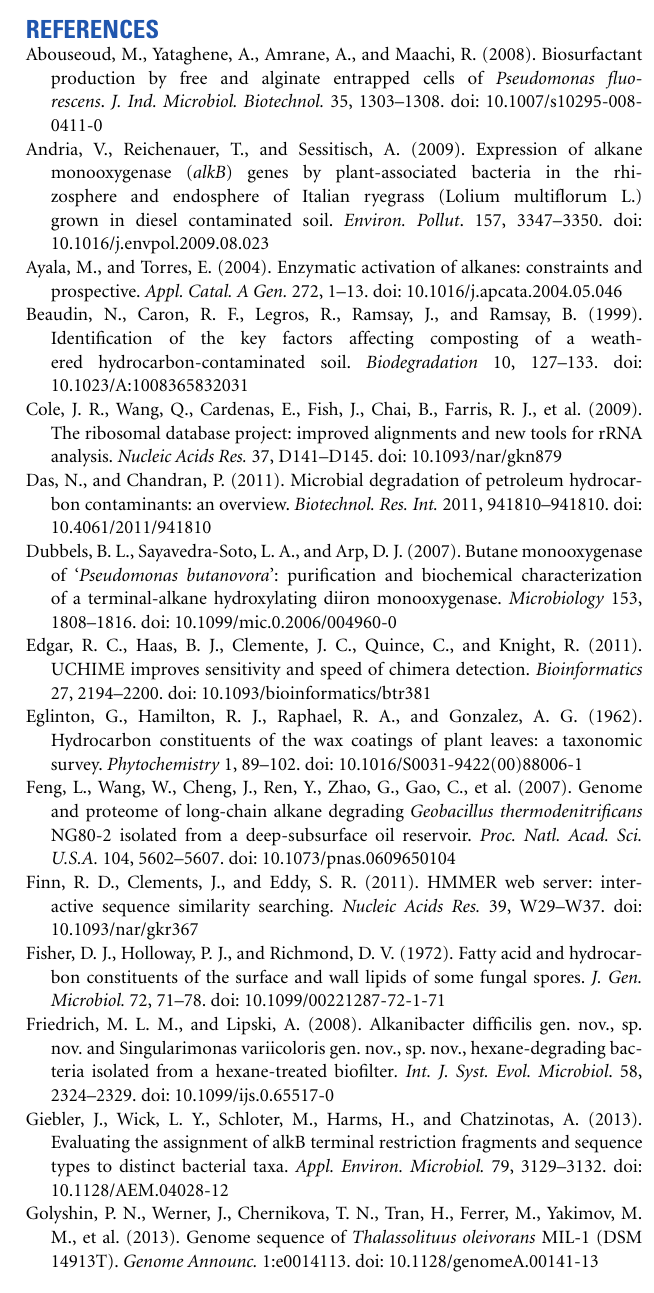
Table S2 | Average total alkane concentrations (mg/kg) with standard errors ( n = 3 ). Different letters indicate statistically significant difference between averages according to Tukey’s multiple comparison test ( P ≤ 0 . 05). Table S3 | alkB gene fragments of amplicon sequencing were included into a phylogenetic ARB tree on amino acid level. Sequences closely related to reference sequences were grouped to clusters. Dashes (–) indicate sequences that could not be assigned to any specific cluster. Table S4 | Distribution of representative sequences within each cluster for each sample as shown in the pie charts presented in Figure 6. Numbers are given in